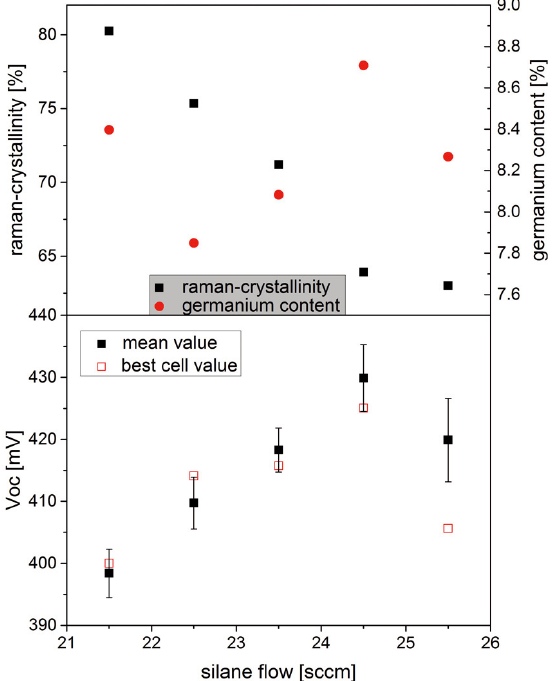
Fig. 1. Raman crystallinity, germanium content and V oc values in relation to the germane flow of single µ c-SiGe:H cells. Best cell values were taken from the best cells in terms of efficiency (true for all figures).